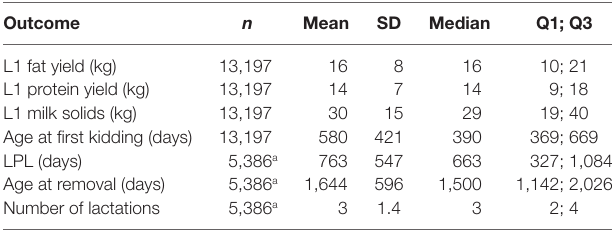
TaBle 1 | Risk factors for culling, sales and deaths in New Zealand dairy goat herds, 2000–2009. Outcome n Mean sD Q1; Q3